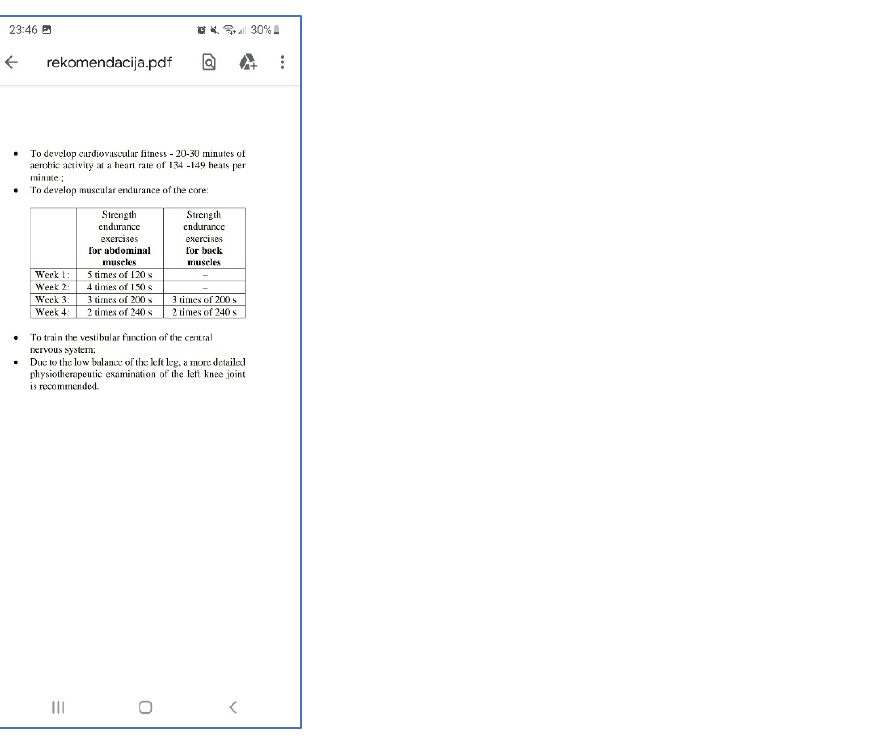
Figure 10. An example of recommendations shown in the mobile application.